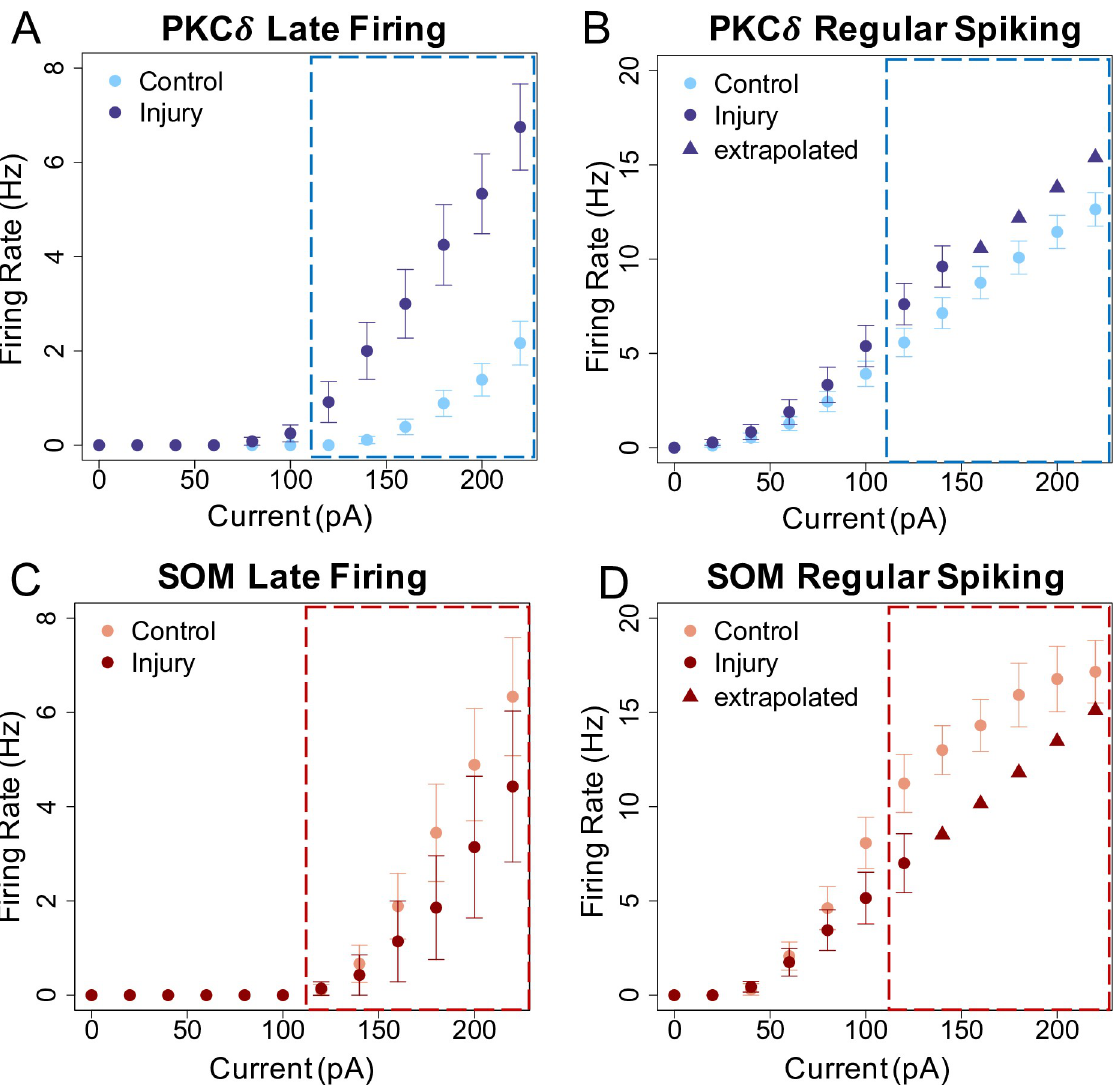
Fig 1. Slice physiology recorded PKC δ and SOM positive neurons in control and injured mice. The firing rate at high current injection of PKC δ positive neurons is higher after injury for both (A) late firing and (B) regular spiking neurons compared to control slices. In contrast, the firing rate at high current injection of SOM positive neurons is lower after injury for both (C) late firing and (D) regular spiking neurons. Triangles represent extrapolated data in B and D for post-injury regular spiking neurons. Boxed values represent firing rates used in model simulations. Some of these raw data have been previously